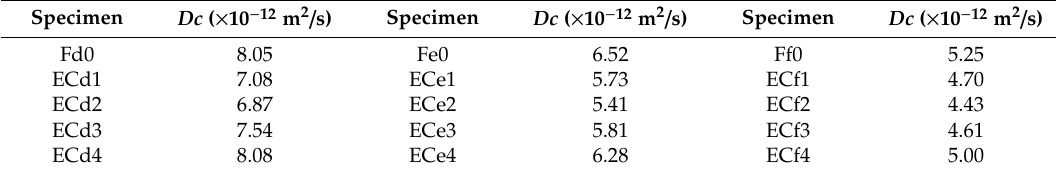
Table 6. Chloride di ff usion coe ffi cient under sustained biaxial stress.